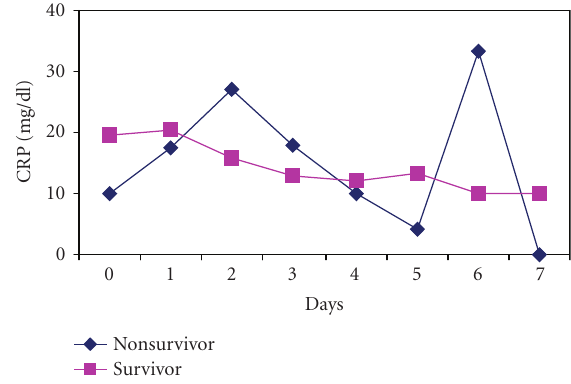
Figure 1: CRP evolution of survivors and nonsurvivors during the first week (NS). NS: not statistically